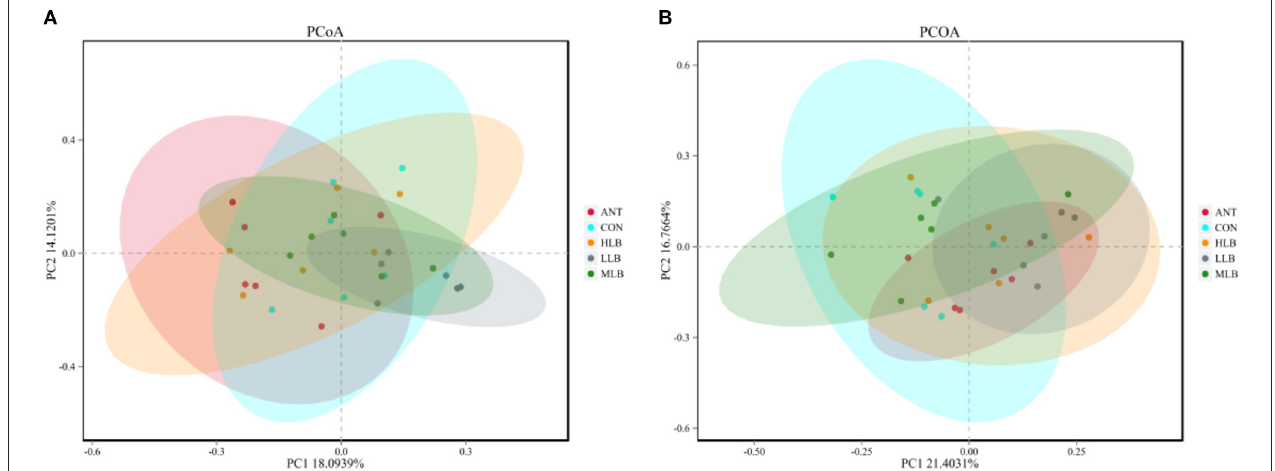
FIGURE 2 | Principal coordinates analysis (PCoA) of microbial communities among groups based on Bray-Curtis distance, n = 6 for each group. CON, control group, basal diet; LLB, basal diet + 200 mg/kg B. licheniformis ; MLB, basal diet + 400 mg/kg B. licheniformis ; HLB, basal diet + 800 mg/kg B. licheniformis ; ANT, basal diet + 150 mg/kg aureomycin. (A) at 21d; (B) at